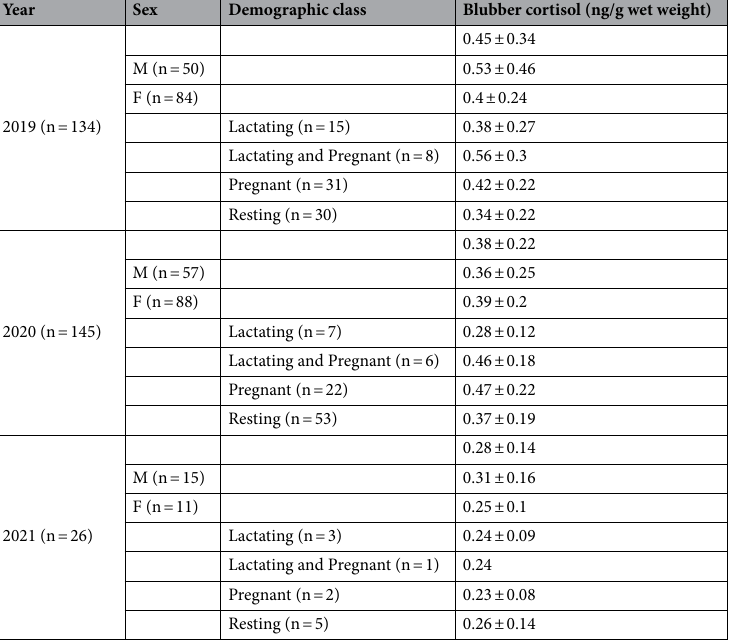
Table 1. Blubber cortisol levels (mean ± SD ng/g wet weight) in biopsied humpback whales across years and different sex and demographic